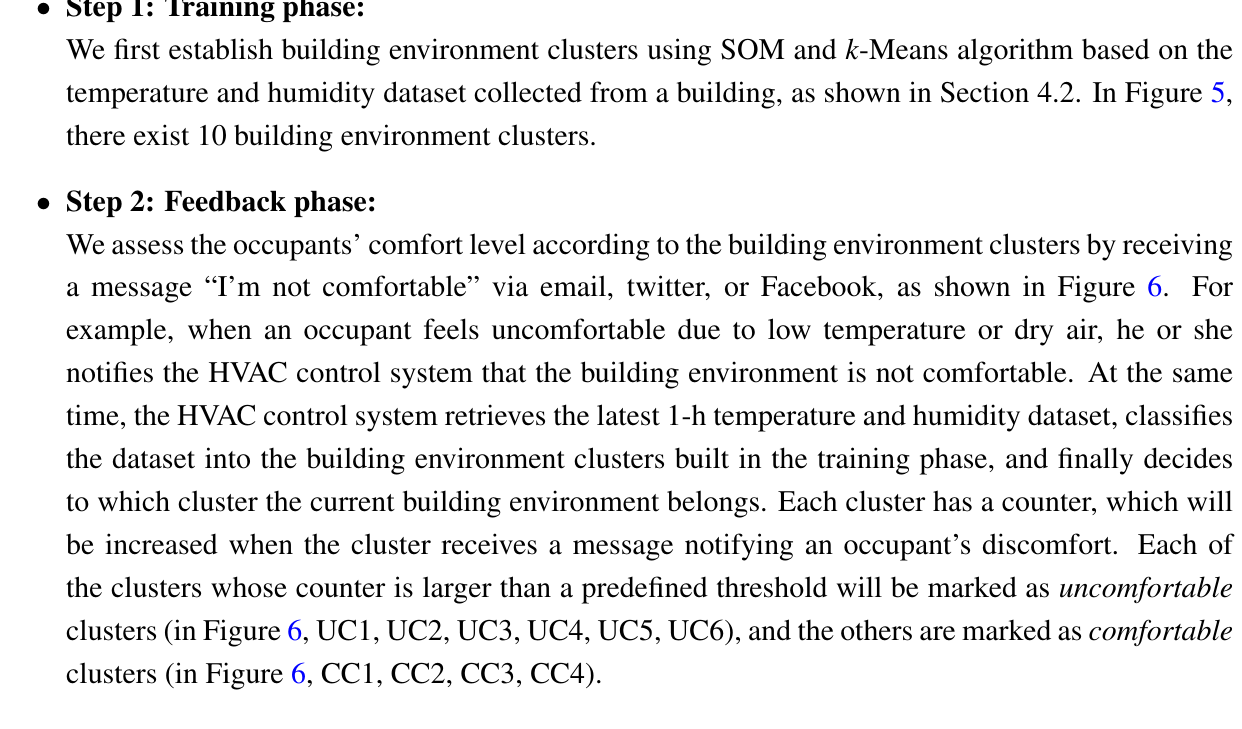
Figure 6. Establishing an occupant comfort map by receiving feedback about building environments through email, Twitter, or